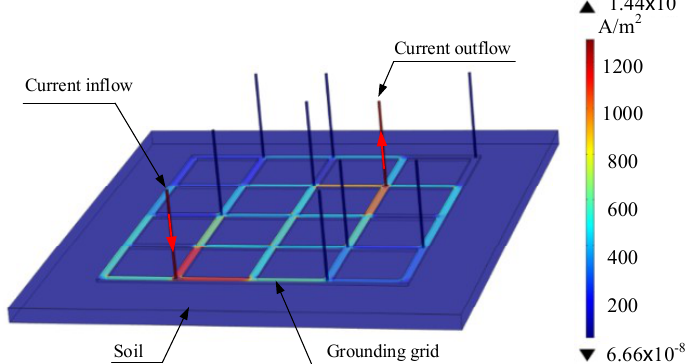
Figure 3. The current density distribution of grid field.